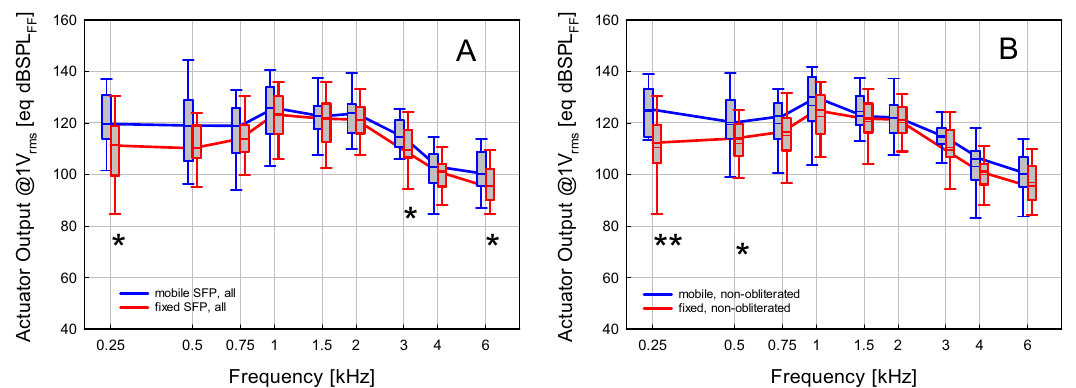
Figure 6. Estimated equivalent sound pressure in sound field [eq dB SPL FF ] generated by the Codacs at an input of 1V rms to the actuator. ( A ) Median responses in mobile (blue, N = 30) and fixed (red, N = 47) stapes footplates of all ears (N = 77). ( B ) Median responses in mobile (blue, N = 21) and fixed (red, N = 43) stapes footplates of non-obliterated ears (N = 64). *p < 0.05, **p = 0.01; Mann–Whitney Rank Sum